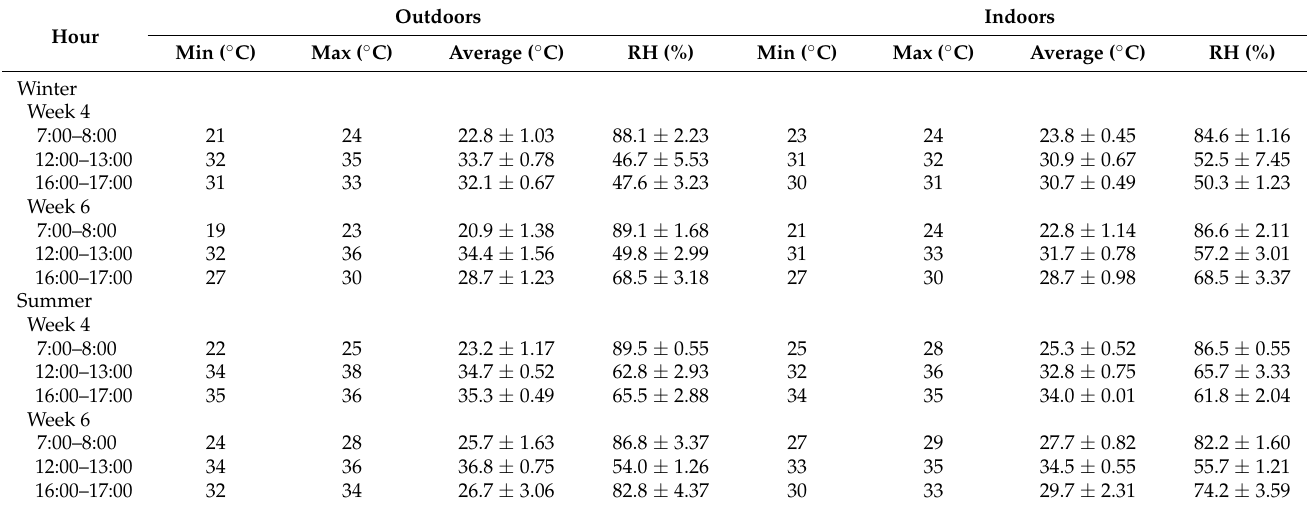
Table 2. Dry bulb temperature ( ◦ C) and relative humidity (RH, %) with standard deviations recorded during the experimental period (abridged from Sanchez-Casanova et al.